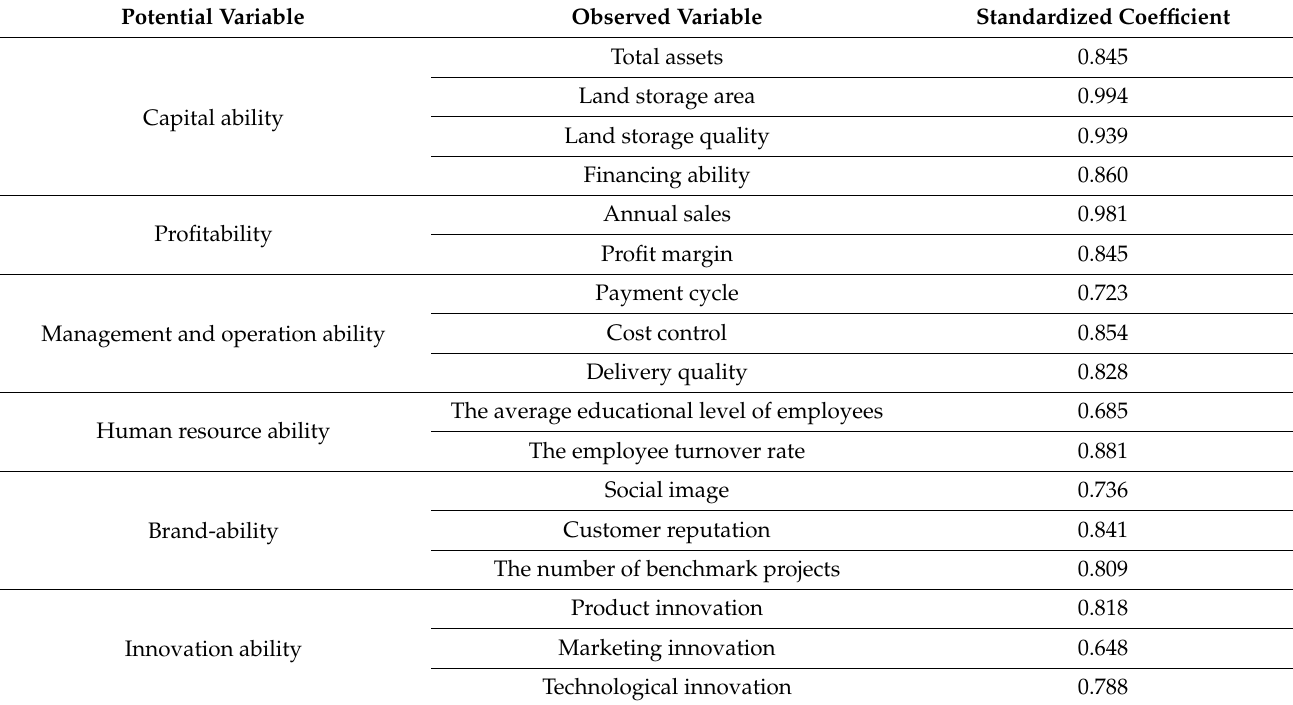
Table 6. The influence coefficients between the potential variable and the observed